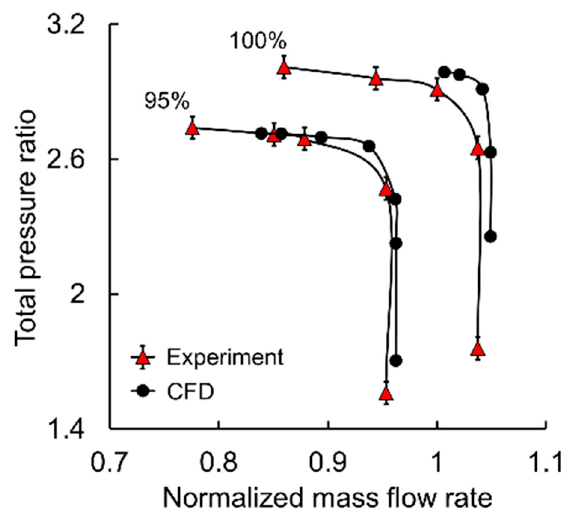
Figure 7. Comparison of pressure ratio of the datum impeller with vaned diffuser. CFD: computational fluid dynamics.